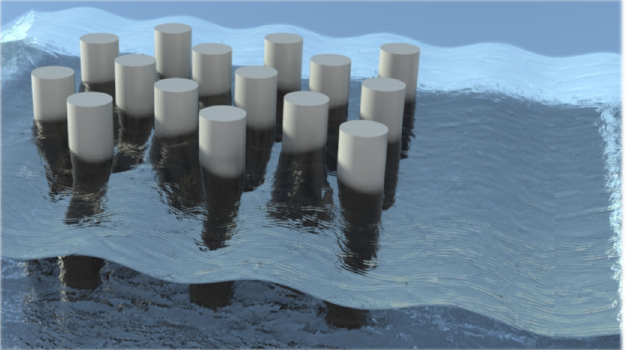
Figure 1. Configuration of the arrangement of vertical cylinders considered as permeable breakwaters.